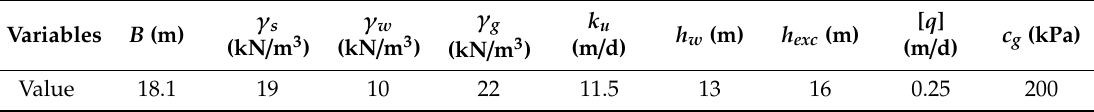
Table 1. Physico-mechanical properties of soil at the site.